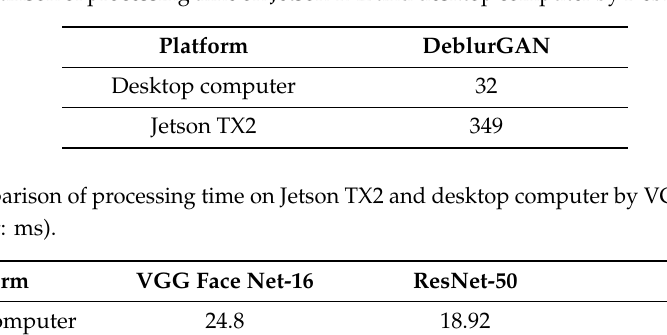
Figure 21. Jetson TX2 embedded system.